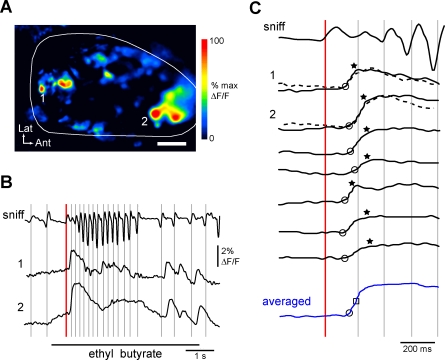
Timing of Exploratory Sniffing Relative to Receptor Input to the Olfactory Bulb(A) “Sniff-triggered average” map of presynaptic calcium signals reflecting ORN input to glomeruli of the dorsal OB evoked by ethyl butyrate (1% s.v.). Map is the average of 31 sniffs in eight trials. “1” and “2” indicate the location of glomeruli whose optical signals are shown in (B) and (C). Scale bar indicates 500 μm. Ant, anterior; Lat, lateral. ΔF, change in fluorescence; F, resting fluorescence.(B) Respiration traces (“sniff,” top) and optical signals from two glomeruli during the first presentation of ethyl butyrate. Vertical lines indicate onset times of each inhalation; red line is the first inhalation after odor onset. Responses become attenuated during high-frequency exploratory sniffing and recover as sniff frequency slows.(C) Expansion of the time around the first sniff after odor onset in (B), showing the responses of the two glomeruli from (A) and (B), plus five additional glomeruli. The latency from the first inhalation to response onset (circle) is approximately 120 ms for each glomerulus; the next inhalation marking the beginning of exploratory sniffing occurs at or before either optical response reaches 90% maximum (star). For glomeruli 1 and 2, dashed traces show the response evoked by the first inhalation of another presentation of ethyl butyrate that did not elicit exploratory sniffing, demonstrating a similar latency and rise time in the optical signal. The blue trace represents the averaged, normalized response of the seven responding glomeruli; the times of the signal onset (circle) and 50% maximum (square) are indicated.